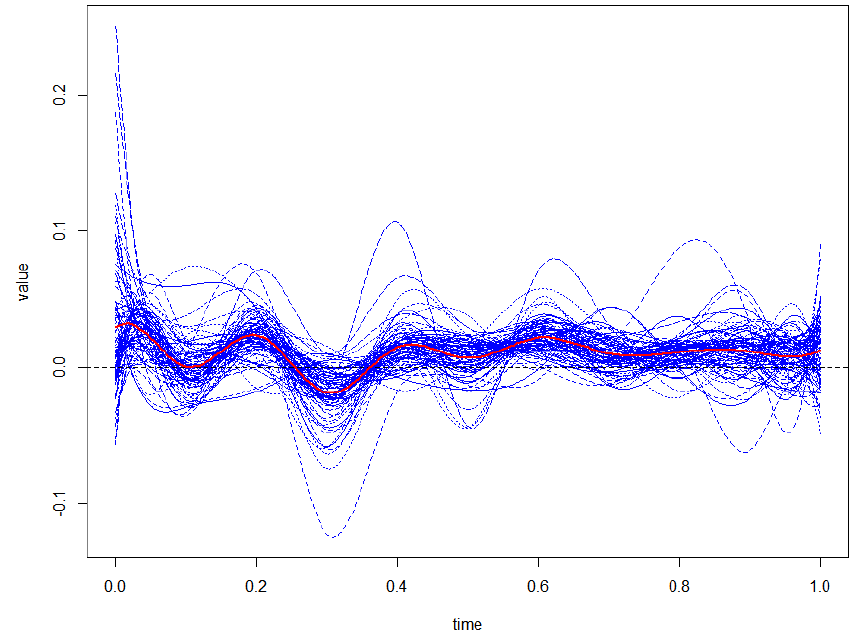
Figure 2. A total of 76 Monthly Log Returns ( blue color ) and the functional mean equation line ( red color ).